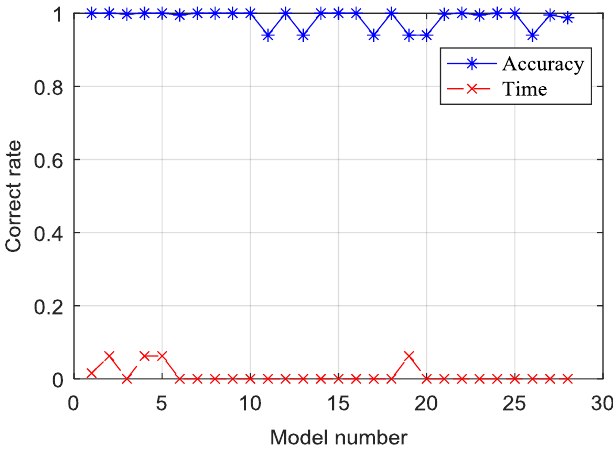
Figure 8. Detection results of each combination model.